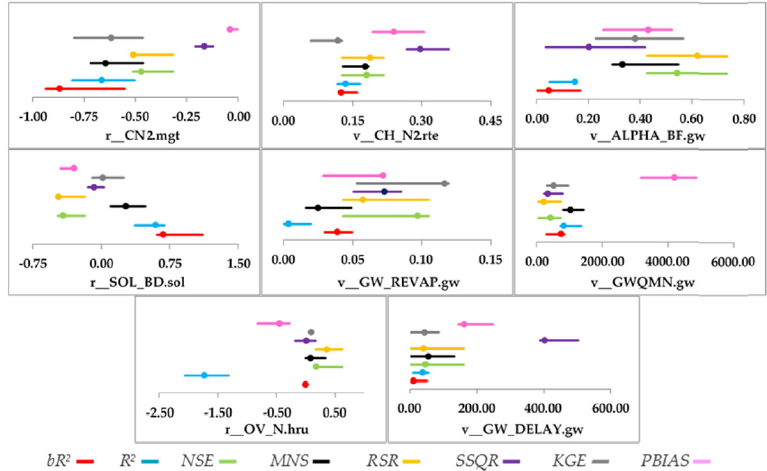
Figure 5. Uncertainty ranges of calibrated parameters using different objective functions for a project in Karkheh River Basin, Iran. The points in each line show the best value of parameters, r_ refers to a relative change where the current values are multiplied by (one plus a factor from the given parameter range), and v_ refers to the substitution by a value from the given parameter range. (Source: Hooshmand et al. [13]).